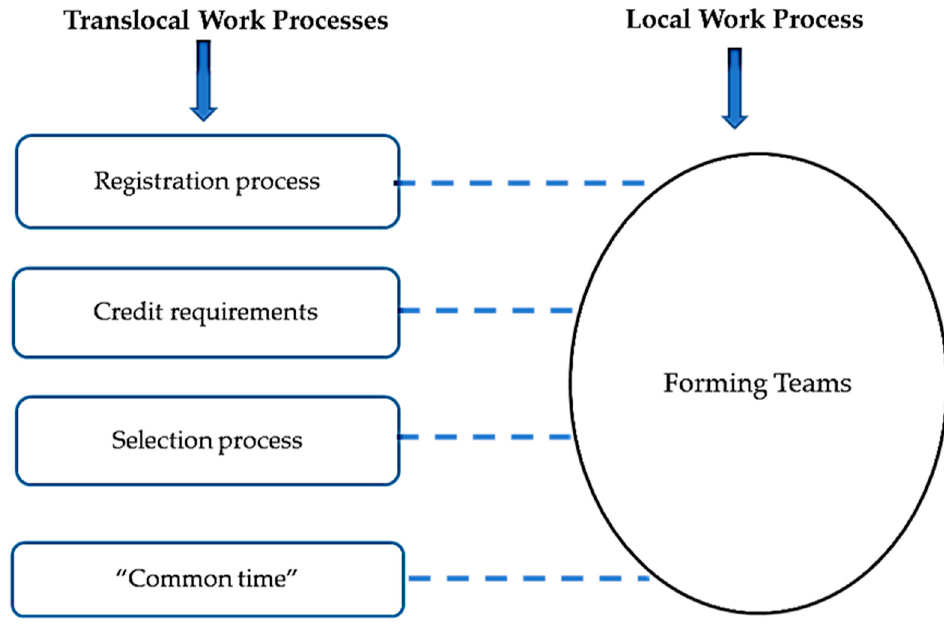
Figure 1. Forming Teams work process.